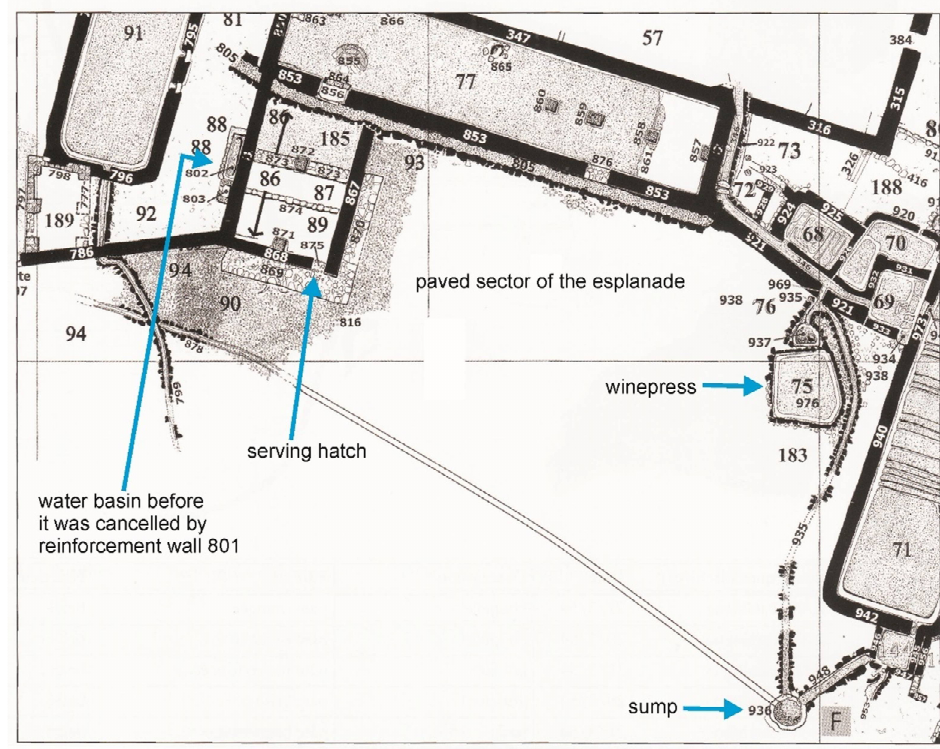
Figure 2. Based on Humbert and Chambon 2016.